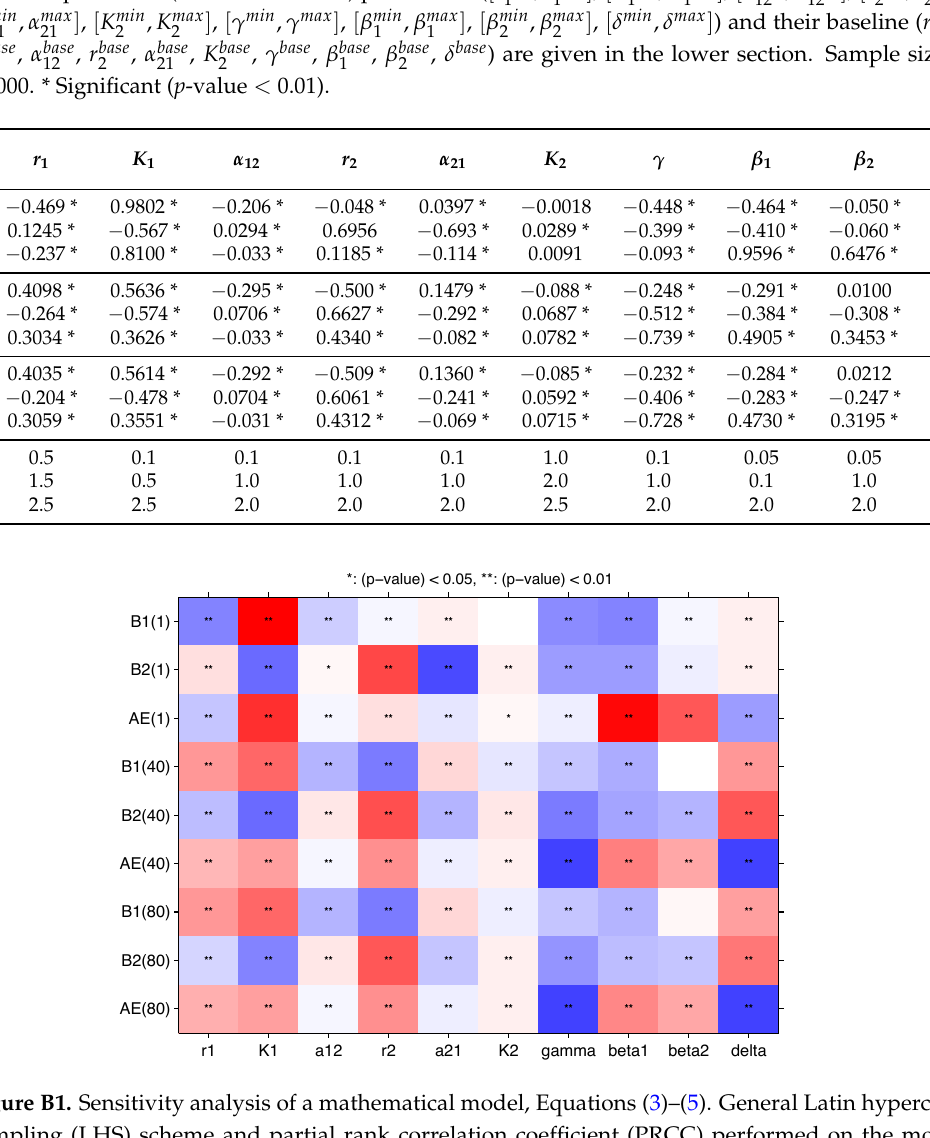
Table B1. Sensitivity analysis for the local ODE system (3)–(5) at time t = 1, 40, 80. Parameters used in sensitivity analysis and PRCC values of populations of bad bacteria ( B 1 ) and good bacteria ( B 2 ) and the concentration of the immune system ( A E ) at various time points ( t = 1, 40, 80) are shown for 10 perturbed parameters r 1 , K 1 , α 12 , r 2 , α 21 , K 2 , γ , β 1 , β 2 , δ . A range (minimum/maximum) of these ten perturbed (non-dimensional) parameters ( [ r min , r max 1 1